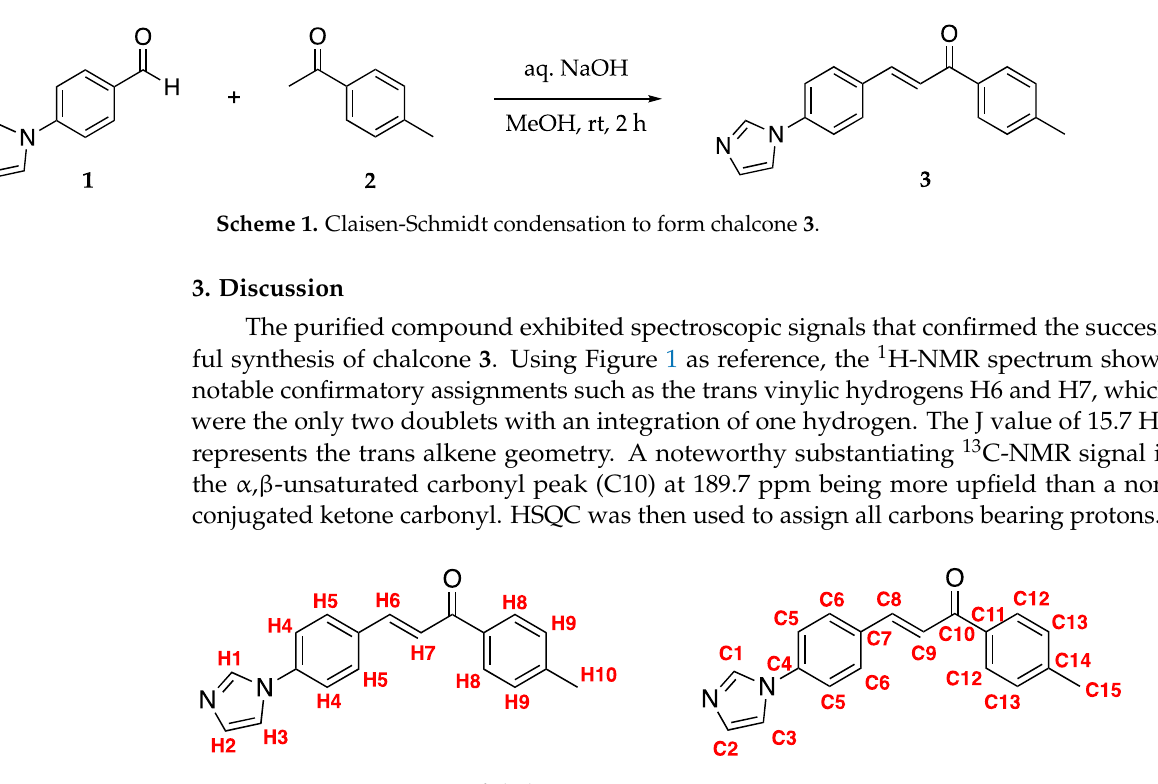
Figure 1. NMR assignment of chalcone 3 .